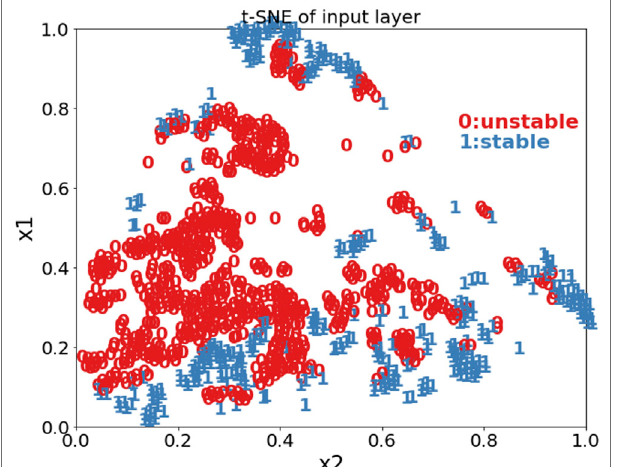
FIGURE 11 | Input layer.